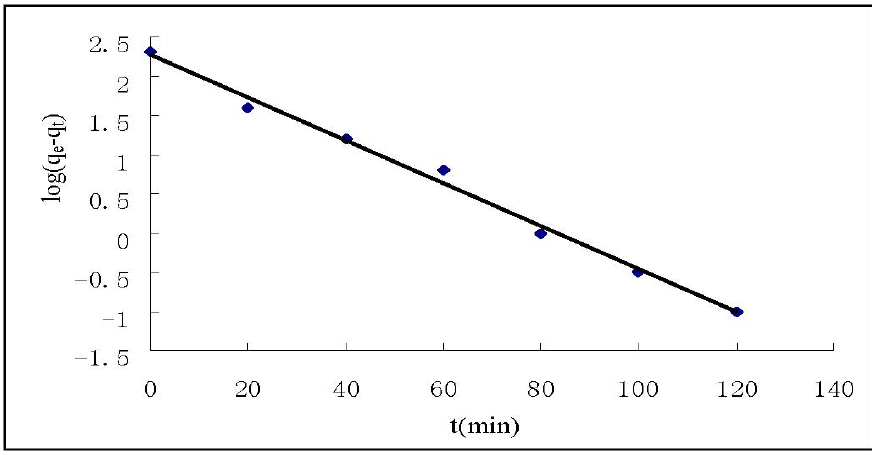
Figure 4. Pseudo first-order kinetic plots for the adsorption of Cr(VI).